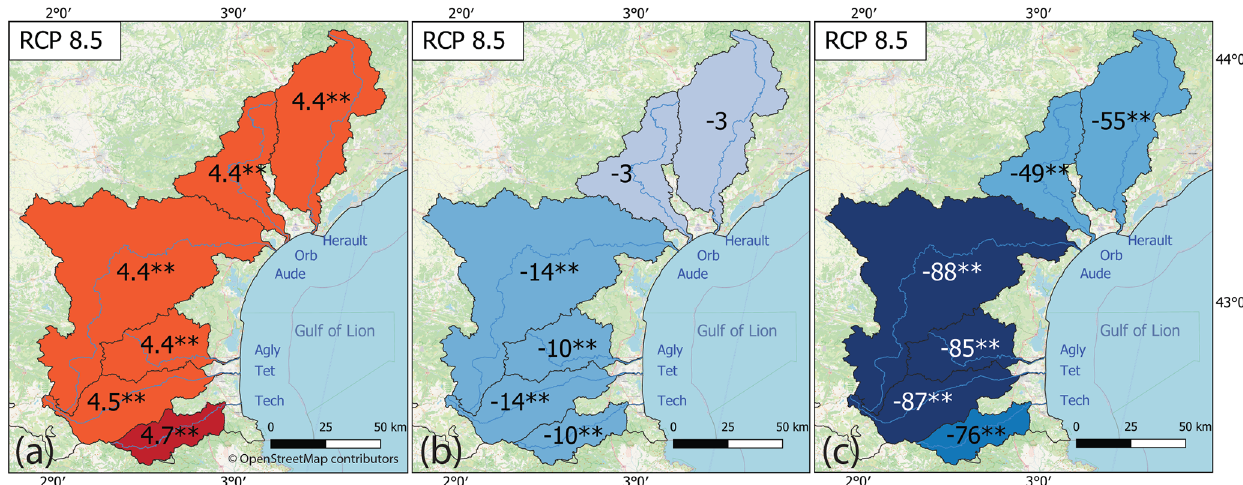
Figure 6. Linear trends for projected annual hydroclimatic variables under a RCP8.5 scenario and for the period 2006–2100. Results are shown for the mean ensemble of the six RCMs used in this study. (a) Temperature (in ◦ C), (b) precipitation (in %), and (c) water discharge (in %). Map data: © OpenStreetMap contributors 2021. Distributed under the Open Data Commons Open Database License (ODbL)